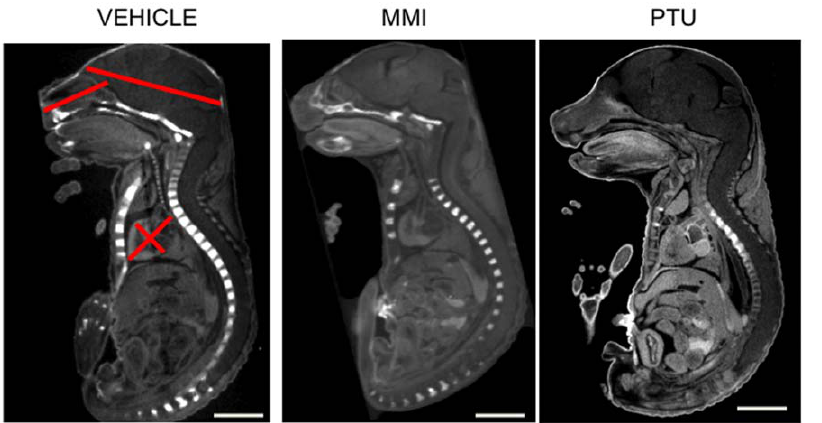
Figure 5. PTU exposure during embryogenesis and effects in E18.5 embryos. Embryos treated in utero from E7.5–E9.5 were analyzed at E18.5. Representative MicroCT scans showing sagittal 3D images of whole embryos indicate no differences between the treatment groups of vehicle, PTU, and MMI. Left panel shows location of morphometic measurements (a. Snout: upper lip to soft palate. b. Fronto-occipital: frontal to occipital lobes. c. Aorta-apex diameter: aortic valve to left ventricular. d. Biventricular diameter: right to left ventricle). Scale bars=5 mm.